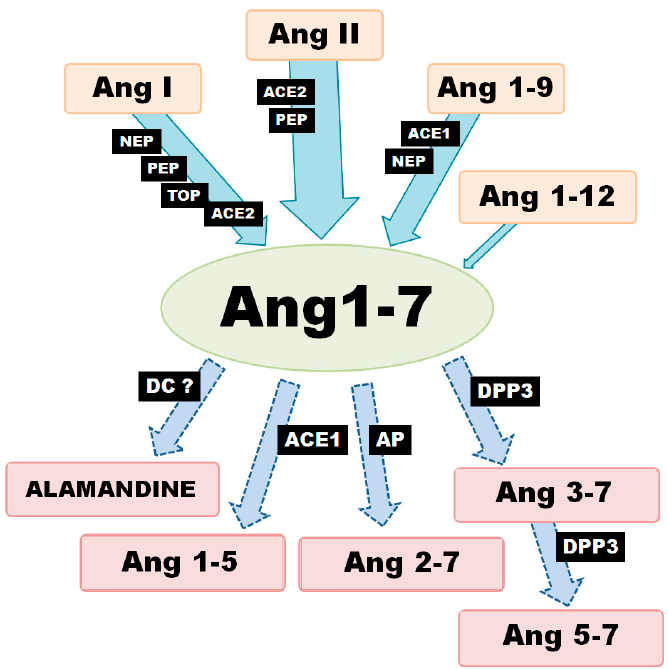
Figure 1. Various enzymatic pathways of Ang-(1-7) synthesis and degradation